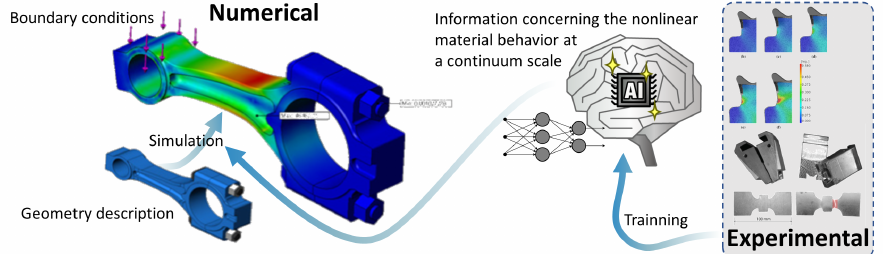
Figure 3. ML model as a full constitutive model, which is implemented into a FEA simulation soft- ware. The ML material model is trained indirectly using full-field measurements from experimental tests. This approach can optionally use empirical known